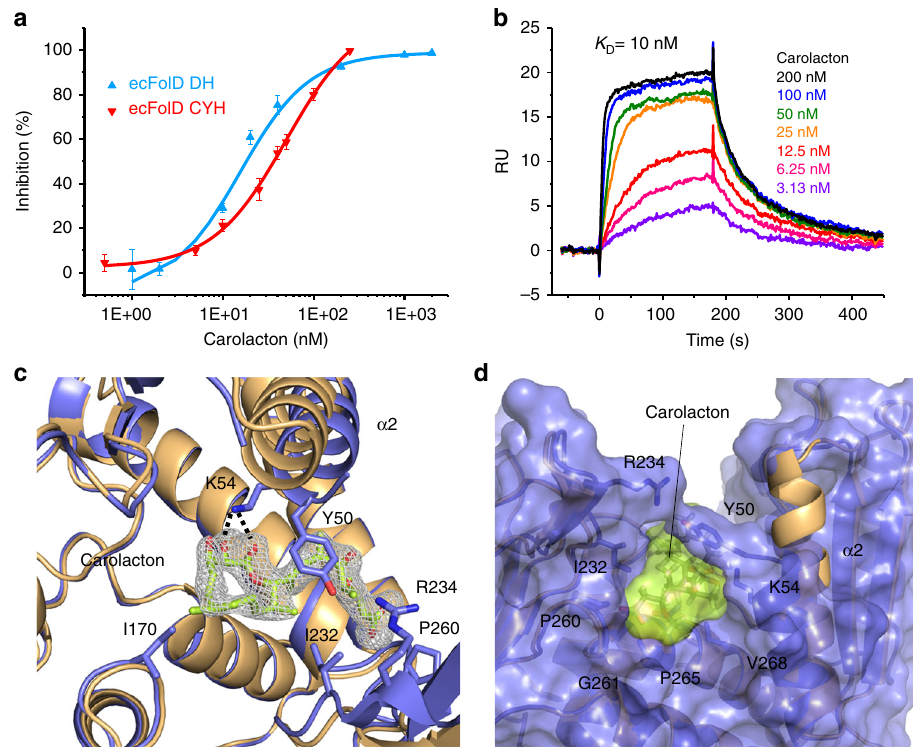
Fig. 2 Carolacton is a potent and tightly binding inhibitor of FolD. a IC 50 determination for carolacton against DH and CYH activities of ecFolD. Data are presented as means ± s.e.m of three independent replicates. IC 50 s were obtained via logistic dose – response fi tting. The one-way ANOVA test was used for statistical analysis, P < 0.01. b SPR analysis of carolacton binding to ecFolD, RU resonance units. Carolacton shows strong binding to ecFolD. The estimated K D was obtained by fi tting the association and dissociation signals with a 1:1 interacton model using the Biacore X100 Evaluation Software. c Top view of the FolD – carolacton complex structure. Cartoon representations of apo-FolD (gold) and FolD in complex with carolacton (blue, lime) are superposed to show the movement and partial dissolution of helix α 2. Residues involved in carolacton binding are shown as sticks. The difference electron density ( F o − F c ) contoured to 3 σ with phases calculated from a model that was re fi ned in the absence of carolacton is shown as a grey isomesh. d Surface representation of FolD bound to carolacton, side-view. Colours correspond to c . Partial dissolution of helix α 2 as a result of the interaction of Y50, which forms a lid